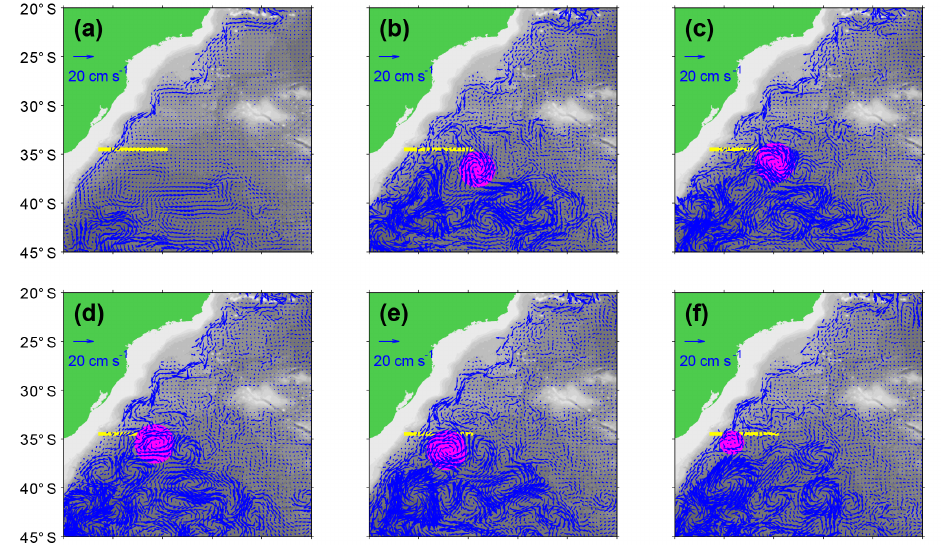
Figure 15. Velocities from the OFES model at the core of the NADW near 2600m depth: (a) average over the full 27-year run described in the text; (b) average over August 1987; (c) average over September 1987; (d) average over October 1987; (e) average over November 1987; and (f) average over December 1987. Land is denoted by green; bottom topography is from the Smith and Sandwell (1997) data set. Yellow line denotes nominal location of the PIES/CPIES array in the real ocean. Magenta disc highlights the propagating eddy and/or wave feature discussed in the